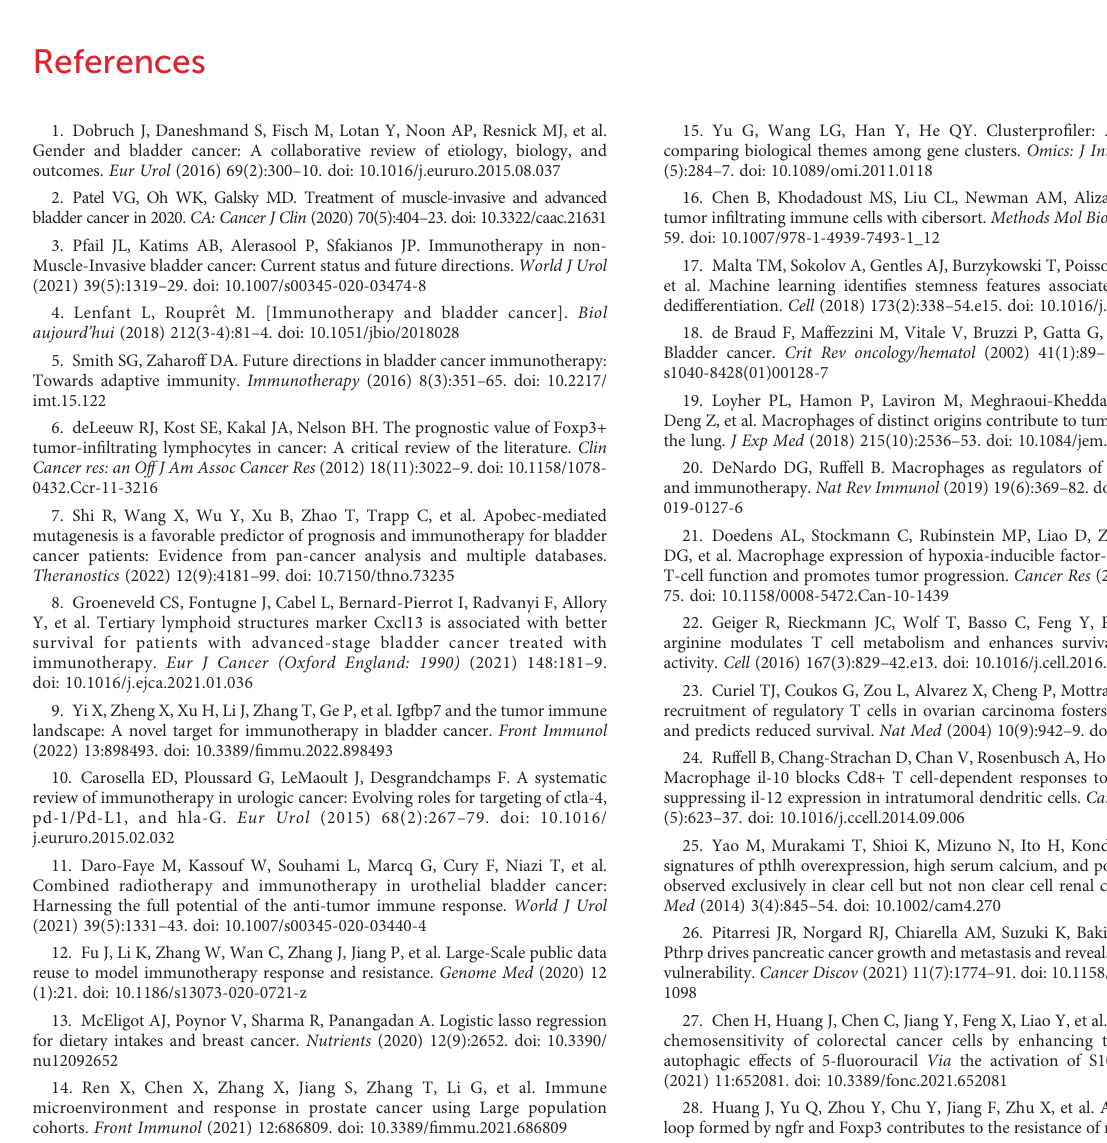
SUPPLEMENTARY FIGURE 3 Machine learning algorithm – LASSO logistics regression.